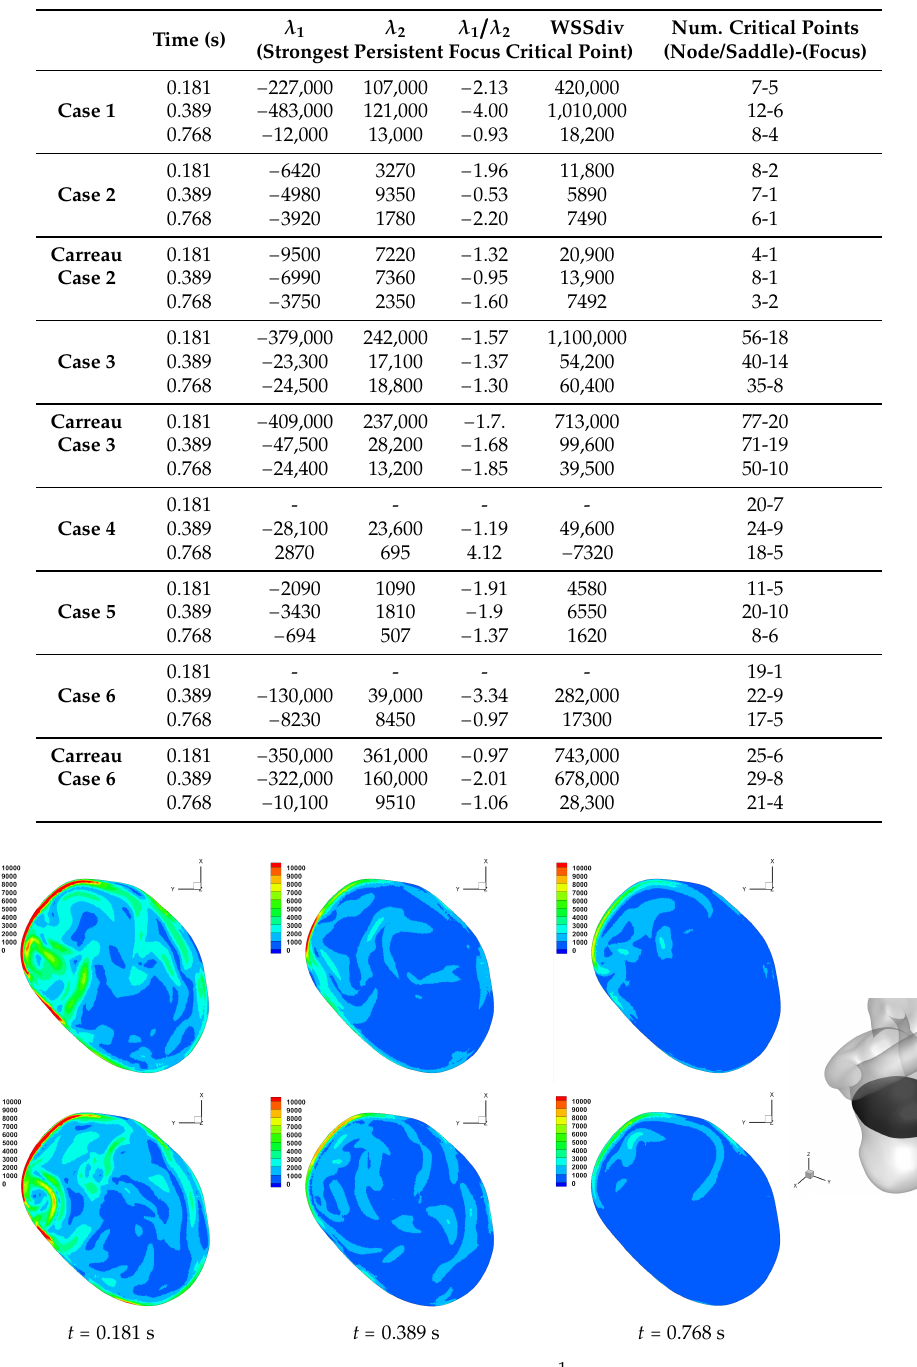
Table 2. Results for the strongest (based on maximum ∣ WSSdiv ∣ ) persistent focus critical point located within the aneurysm. Note: for Case 4 no persistent focus critical point was present and hence different points are reported; for Case 6 the persistent focus critical point only appeared from end systole to end diastole. The total number of critical points within the aneurysm are also reported at each time instance (right column). Units: WSSdiv (Pa m − 1 ), WSS (Pa). Results are presented to three significant figures.